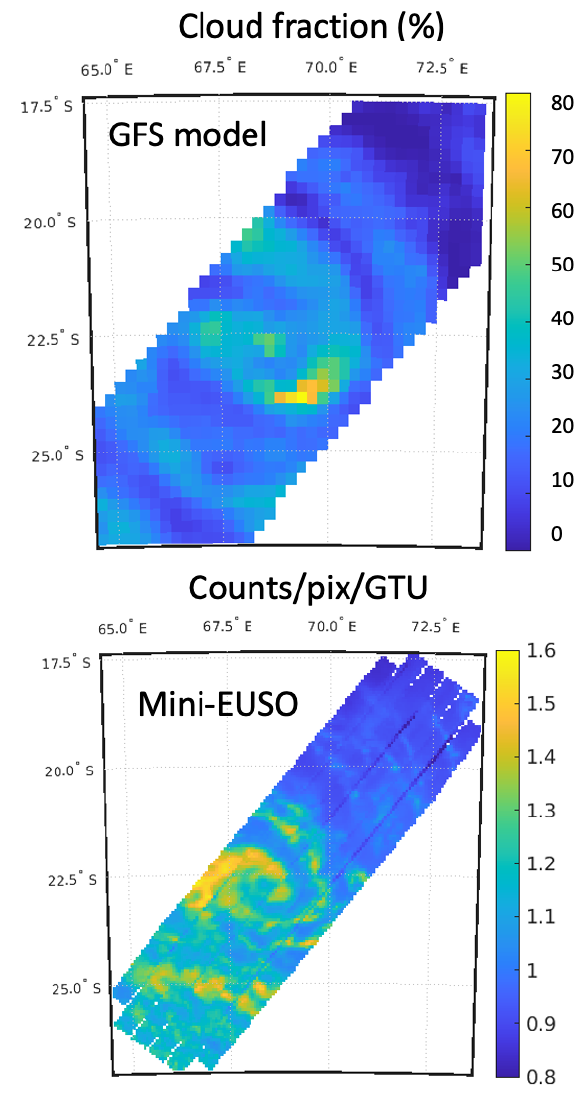
Figure 3. The top panel shows the cloud fraction (%) due to a cyclon in the Indian ocean as foreseen by the GFS atmospheric model [23] and the bottom panel shows the Mini-EUSO counts per pixel and D1 GTU. Where the cloud fraction is expected to be higher, Mini-EUSO registers higher counts level. Figure adapted from